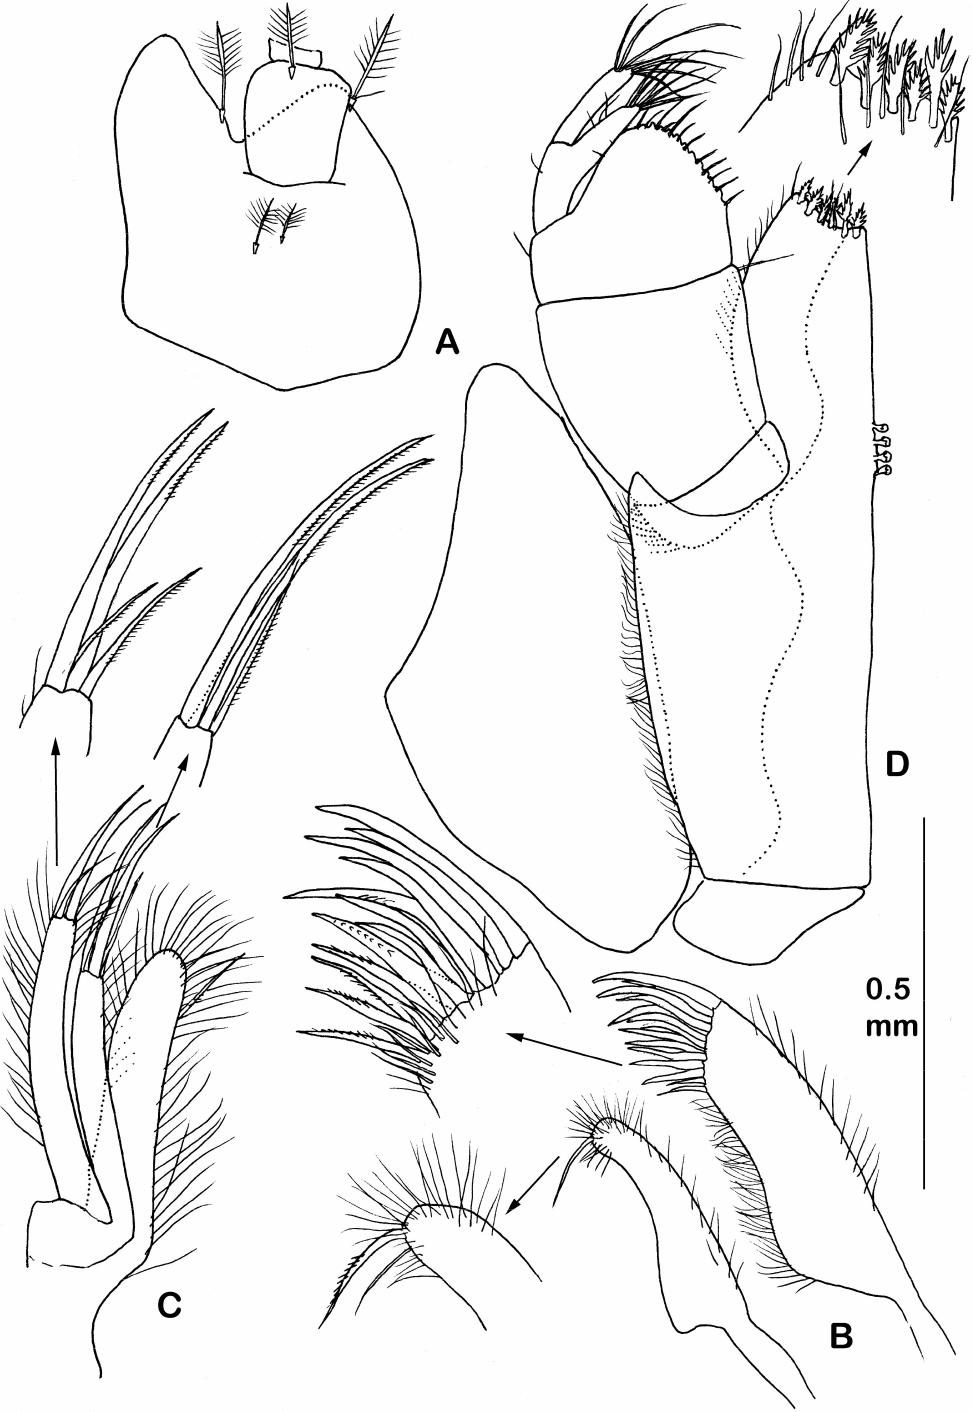
Figure 11. Eurycope dahli Svavarsson, 1987. Male (ZMH K-45609): ( A ) antenna I, articles 1 and 2; ( B ) maxilla I (distal parts enlarged); ( C ) maxilla II (distal parts enlarged); ( D ) maxilliped (distal parts of endite